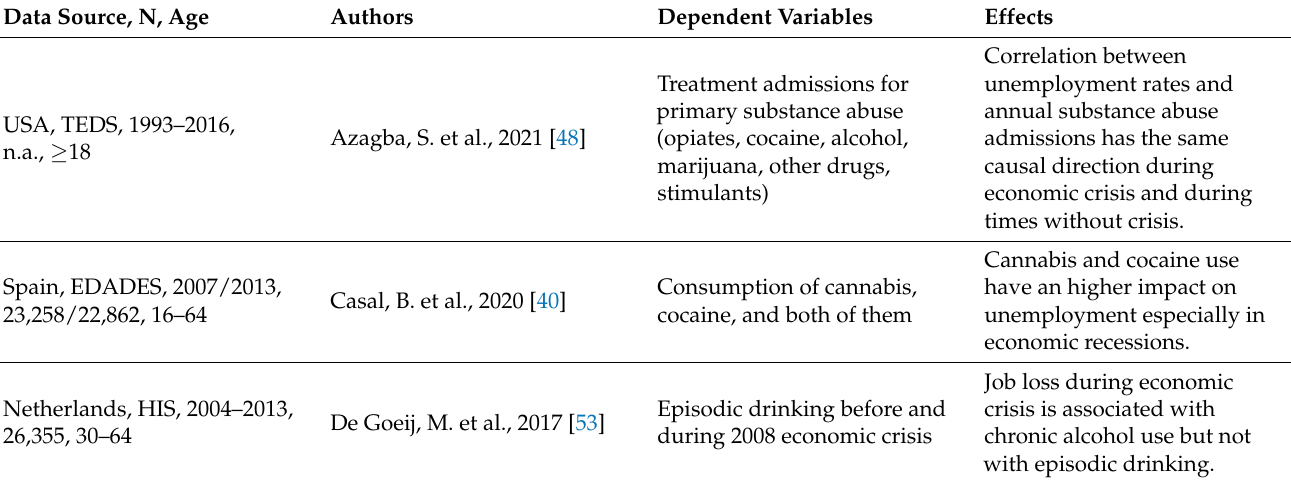
Table 6. Substance-use patterns based on unemployment rates and business cycle/cyclical